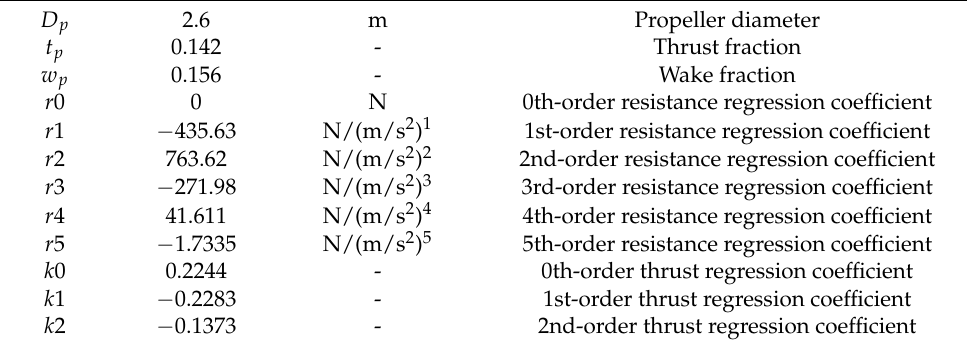
Table 38. Resistance and propulsion parameters of the fishing vessel.